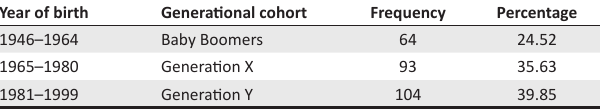
TABLE 2: Generational cohorts.